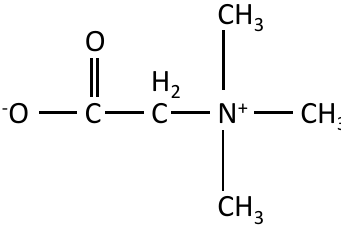
Figure 1. The chemical structure of glycinebetaine.